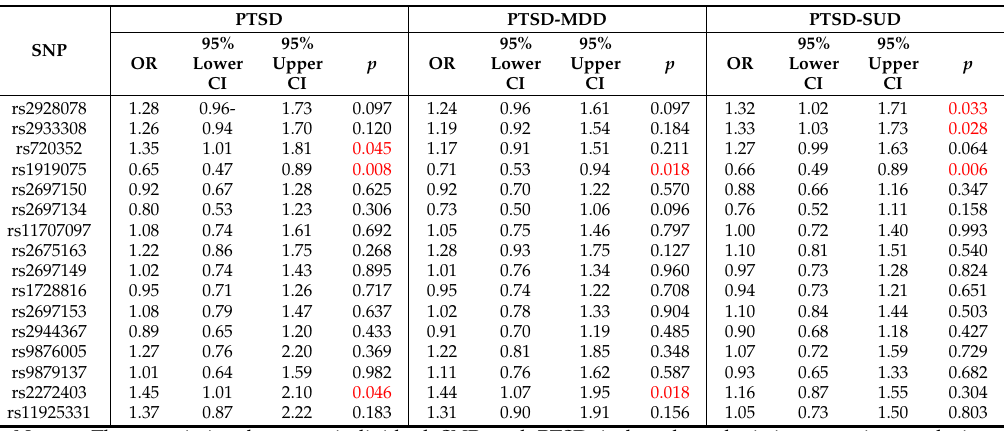
Table 3. The effect of each SNP on the risk of PTSD (i.e., individuals with only Posttraumatic Stress Disorder), PTSD-MDD (i.e., comorbid Posttraumatic Stress Disorder and Major Depressive Disorder), and PTSD-SUD (i.e., comorbid Posttraumatic Stress Disorder and Substance Use Disorder), adjusting for age, race, sex and